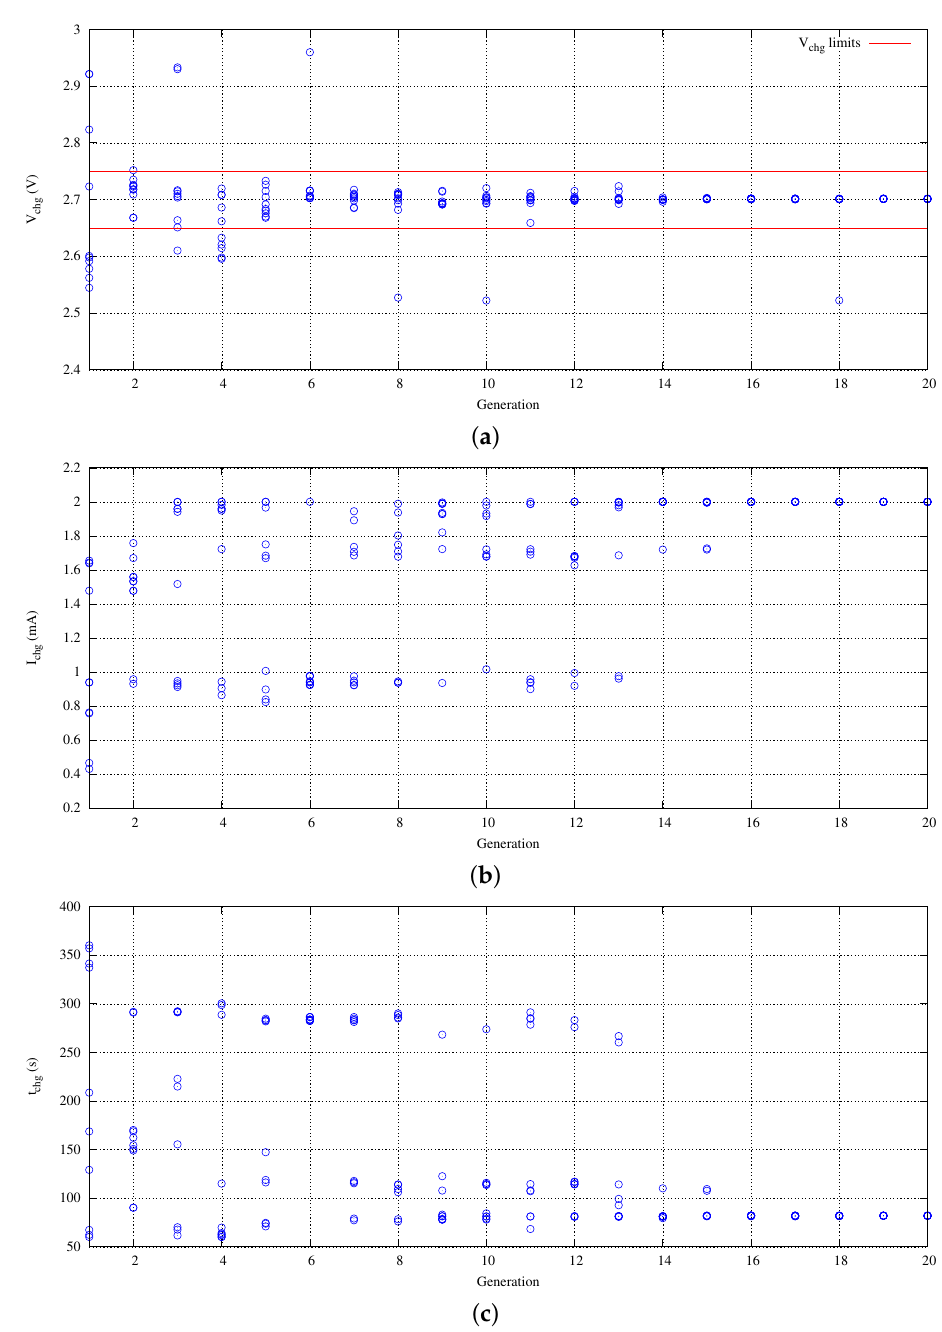
Figure 7. NSGA-II approach convergence: ( a ) obtained charging voltage, ( b ) required charging current, and ( c ) required charging